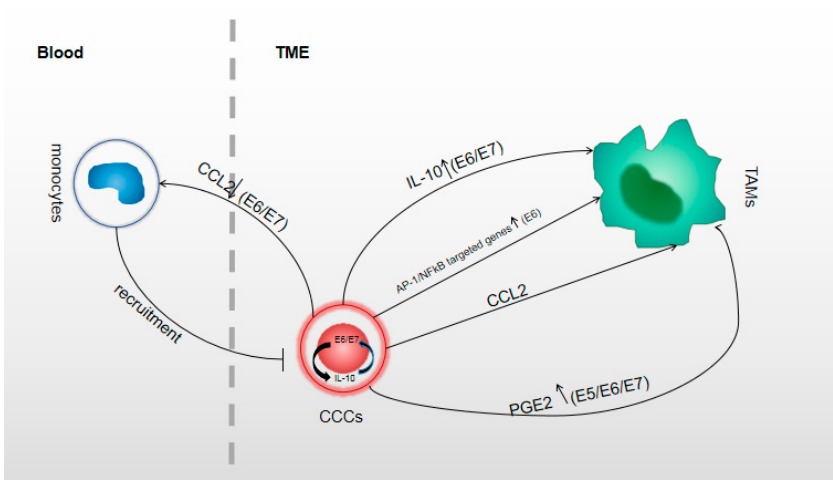
Figure 1. This figure shows the relationship between human papillomavirus (HPV) oncoproteins and the molecules from CC cells acting in formatting TAMs. In circulating blood, CCL2 (left) was regulated inversely by E6 or E7 [64], and the less expressed CCL2 recruited fewer monocytes into local tumor tissue [30]; IL-10 was upregulated by E6 or E7 and E6 and E7 were upregulated by IL-10 as a circulation in CC cells [65]; Increasing IL-10 could act in M2 polarization process [44]; Transcriptional factors AP-1 and NF κ B targeted genes that act in M2 polarization were upregulated by E6 [38]; CCL2 (right) was expressed individualized [30,40,44,66] and CCL2 + CC cells could promote the M2 polarization [30,40]. The molecules which regulated CCL2 expression that act in M2 polarization was unclear. PGE2 which acted in M2 polarization was upregulated by E5 or E6 or E7 [67,68]; TME, tumor microenvironment; CCL2 is the alternative name of monocyte chemoattractant protein (MCP-1); IL-10, interleukin 10; CC cells, cervical cancer cells.